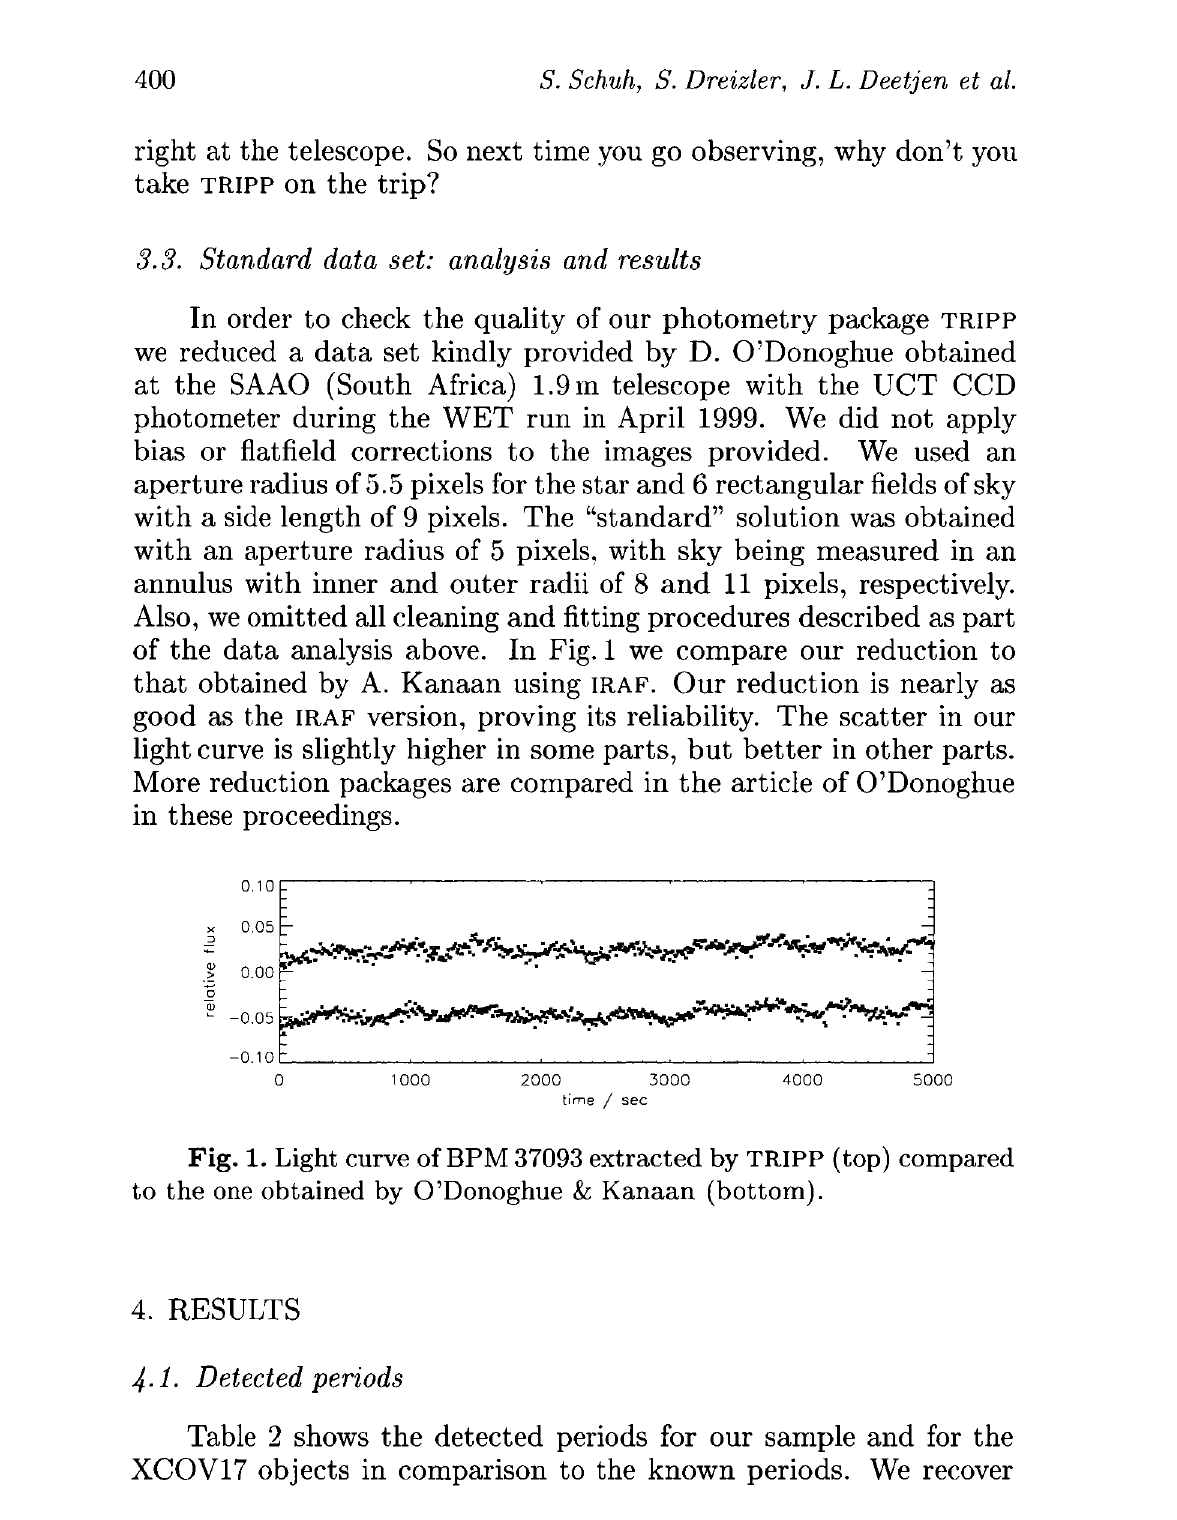
Fig. Light curve of BPM 37093 extracted by TRIPP (top) compared to the one obtained by O'Donoghue & Kanaan